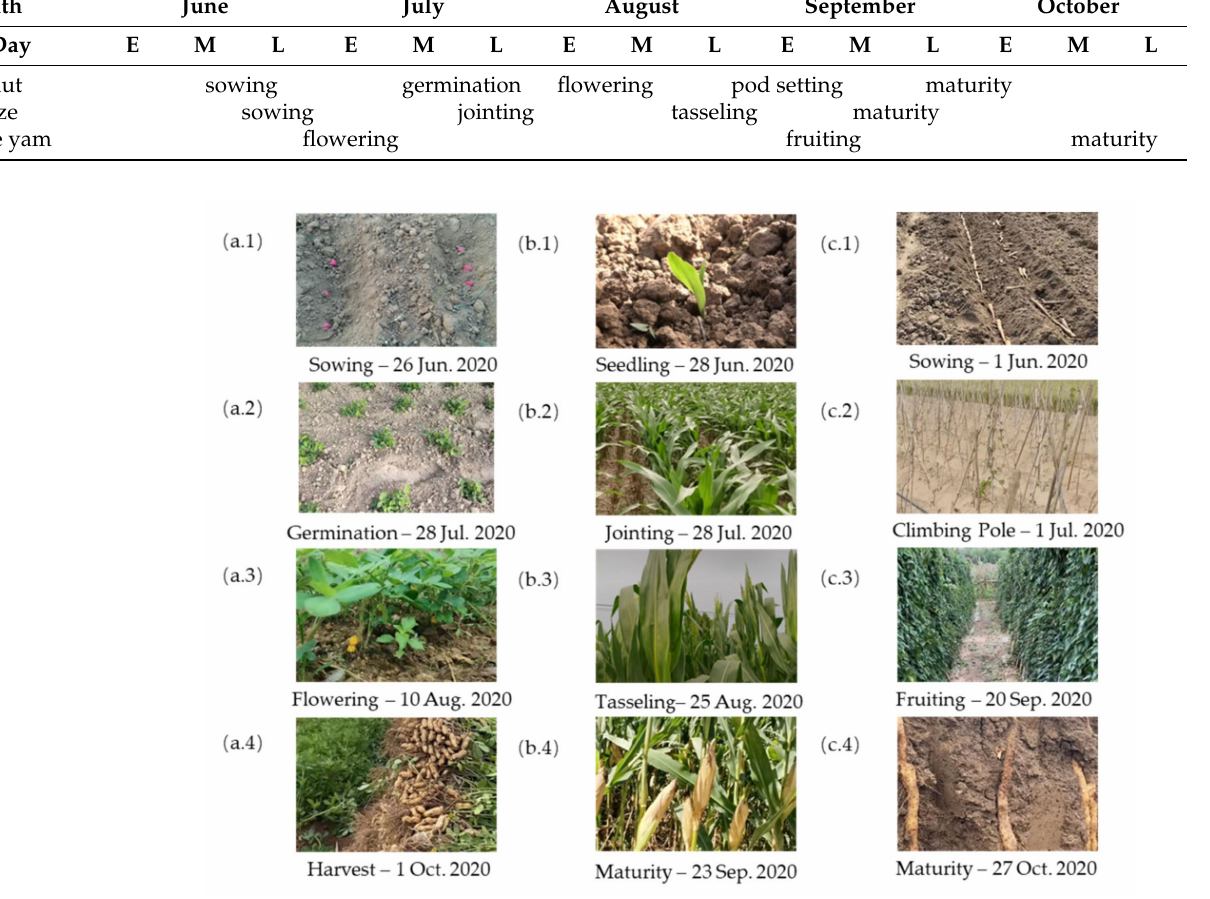
Figure 2. ( a.1 – a.4 ) Images of peanuts at sowing, germination, flowering, and harvest, respectively. ( b.1 – b.4 ) Images of maize at seedling, jointing, tasseling, and maturity, respectively. ( c.1 – c.4 ) Images of Chinese yam at sowing, climbing pole, fruiting, and maturity,